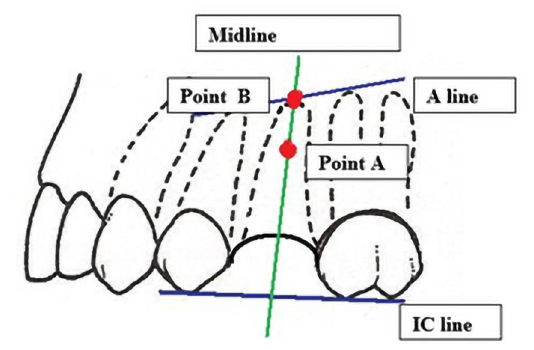
Figure 8. Grayscale value measurement points.